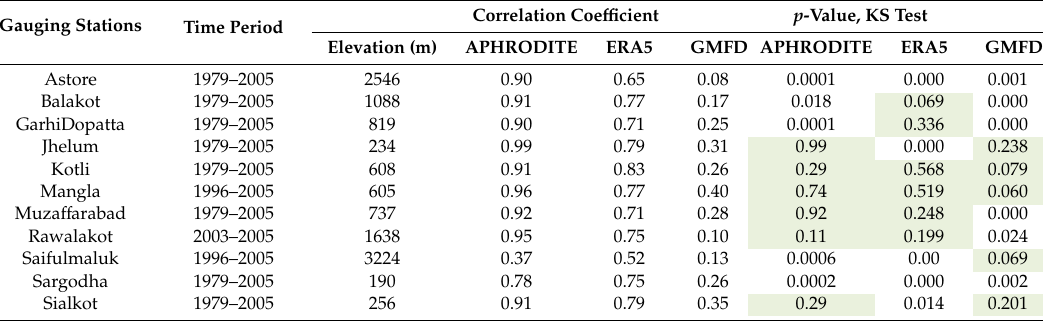
Table 1. Comparative analysis of APHRODITE and ERA5 monthly dataset. Pearson correlation coe ffi cients and Kolmogorov Smirnov Test results (KS Test). (The shaded p -Values are > 0.05, depicting the null hypothesis of similar distribution, is not